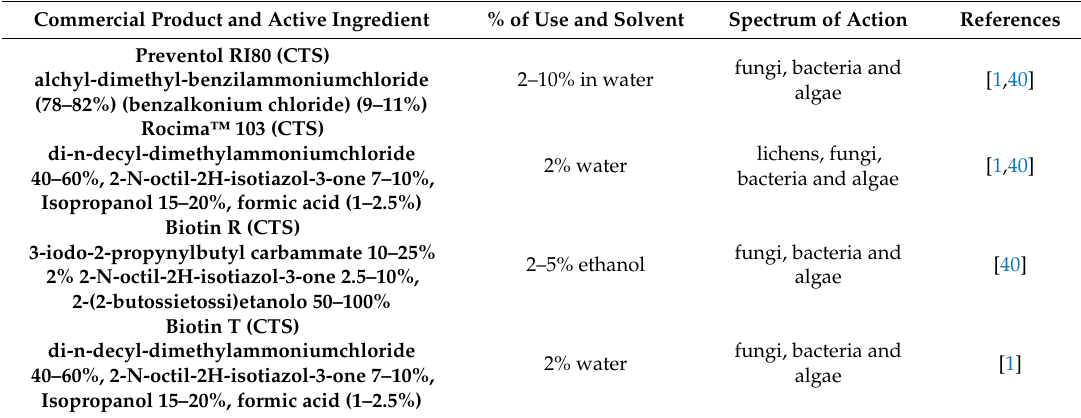
Table 1. List of most common biocides used in